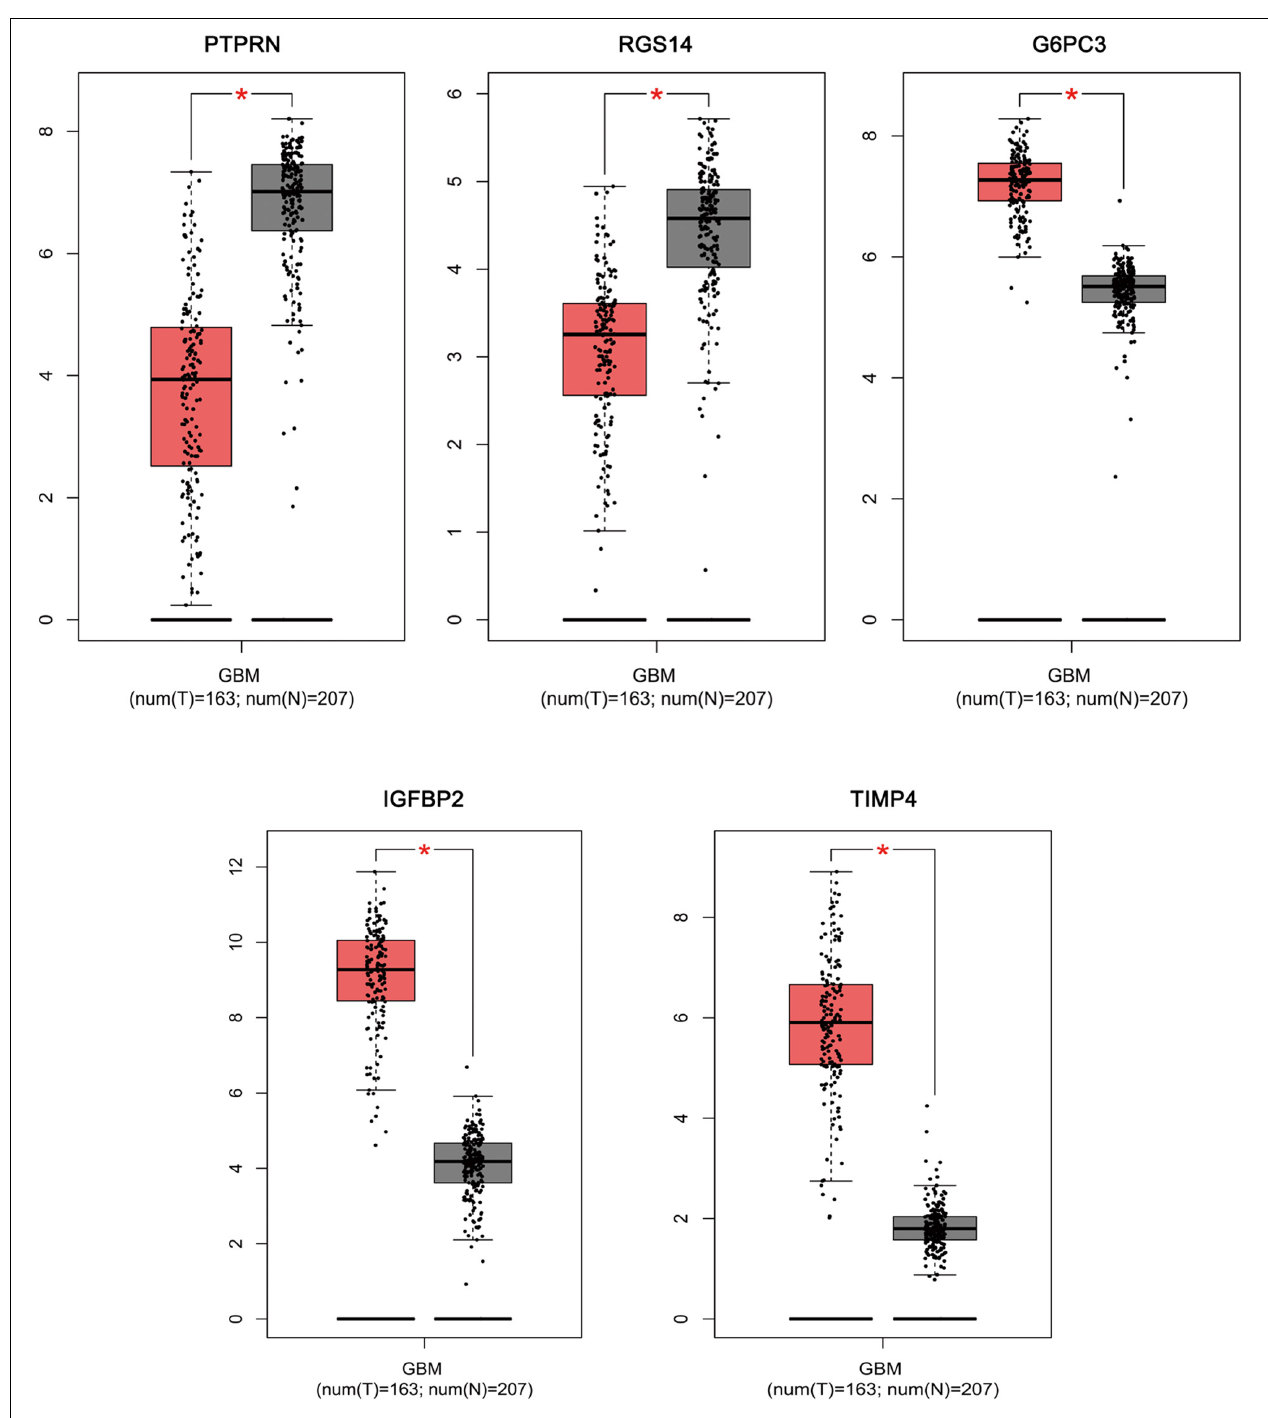
FIGURE 6 | Comparisons of the expression of the five genes between GBM and non-GBM tissues in TCGA and GTEx based on GEPIA. The Y axis represents the log2 (TPM + 1) for gene expression. The gray bar indicates the non-GBM tissues, and the red bar shows the GBM tissues. These figures were derived from GEPIA. TPM: transcripts per kilobase million. ∗ p <